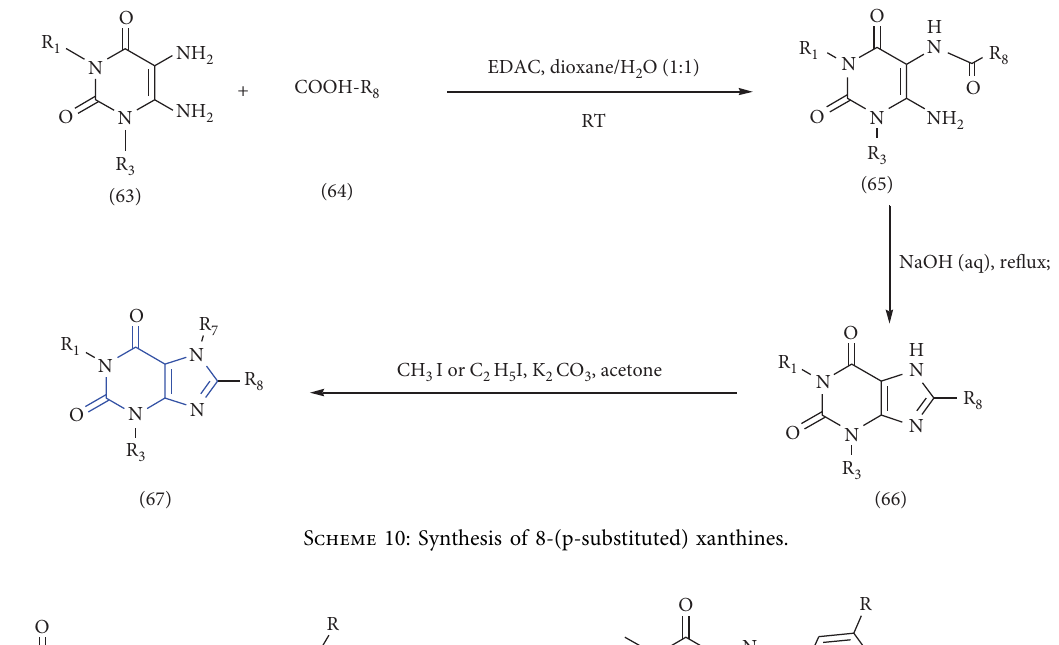
Scheme 10: Synthesis of 8-(p-substituted) xanthines.